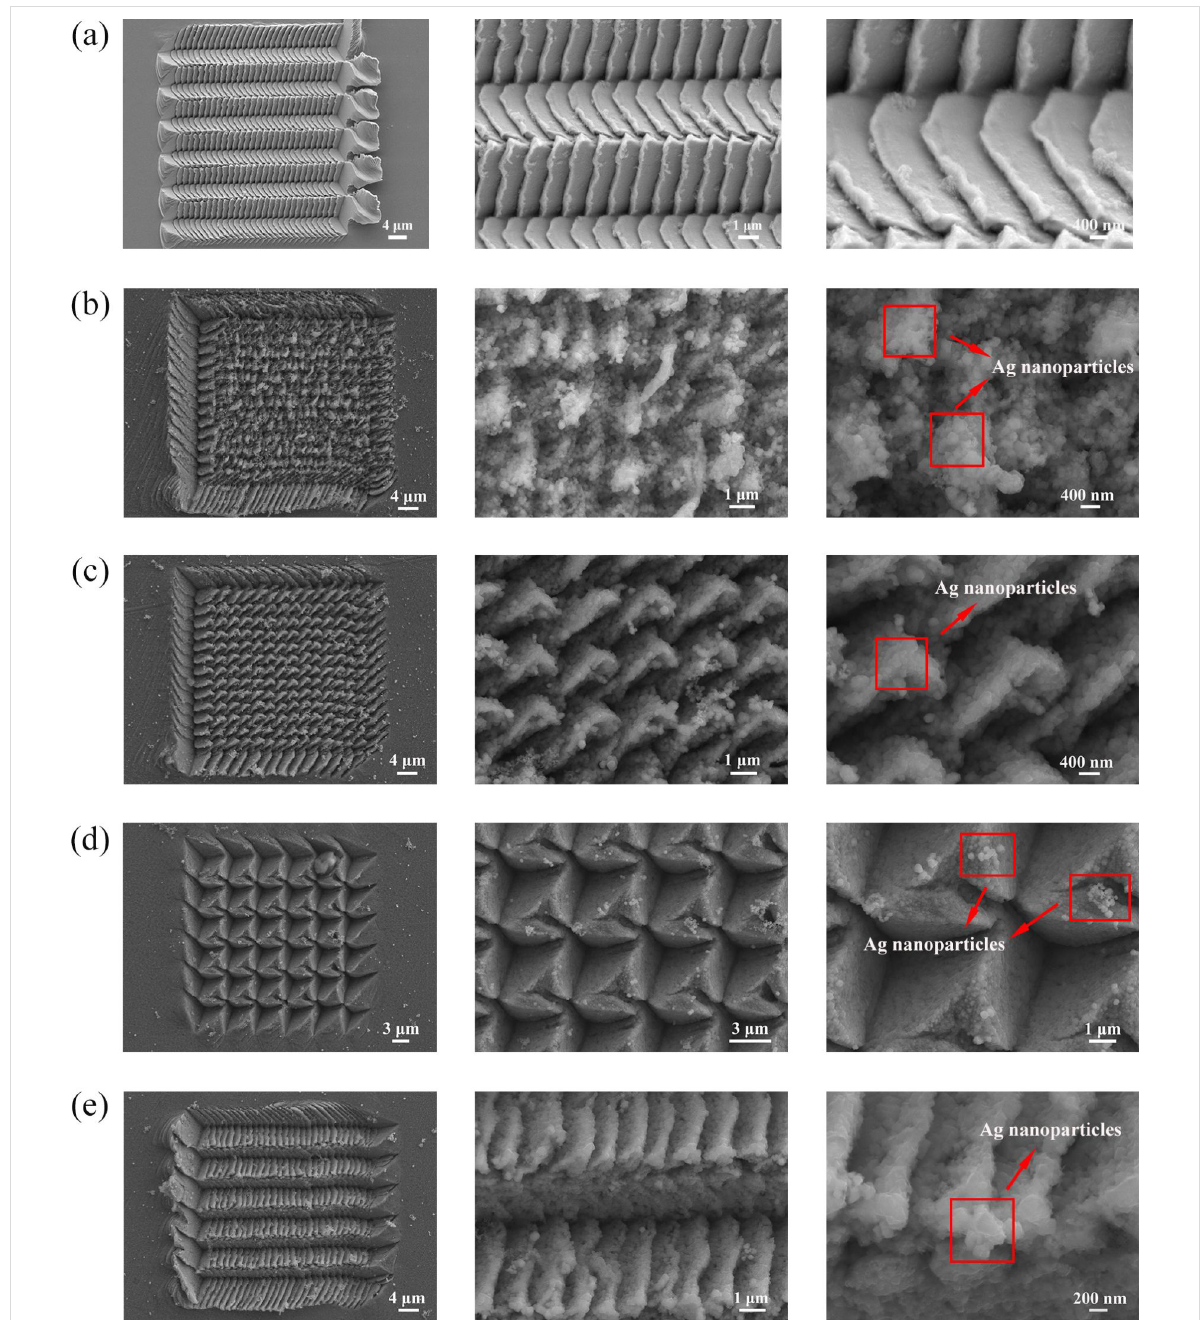
Figure 1: SEM images of the arrayed triangular cavities with different feeds in AgNO 3 solution before and after 5 minutes: (a) f x = 5 μ m and f y = 1 μ m before using AgNO 3 solution, (b) f x = 2 μ m and f y = 1 μ m after using AgNO 3 solution, (c) f x = 2 μ m and f y = 2 μ m, (d) f x = 5 μ m and f y = 5 μ m, (e) f x = 5 μ m and f y = 1 μ